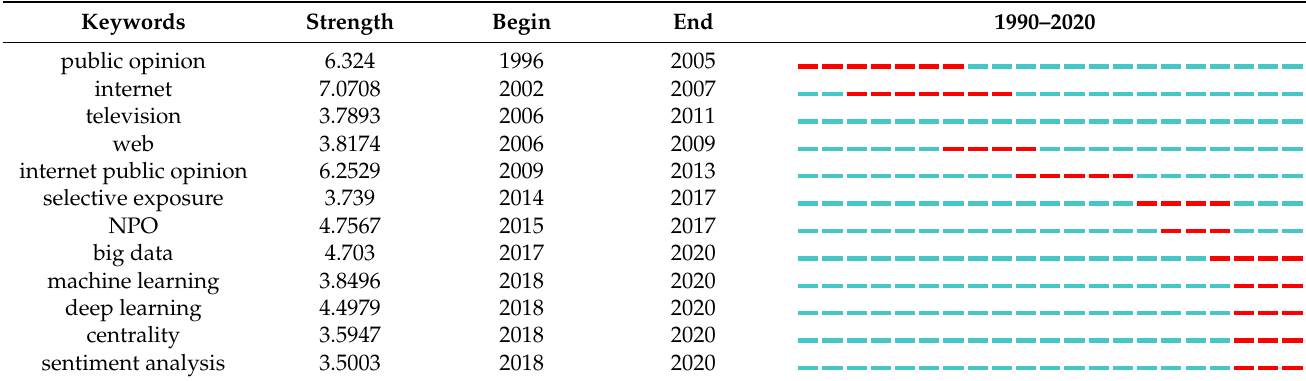
Table 8. Top 12 Keywords with the Strongest Citation Bursts,